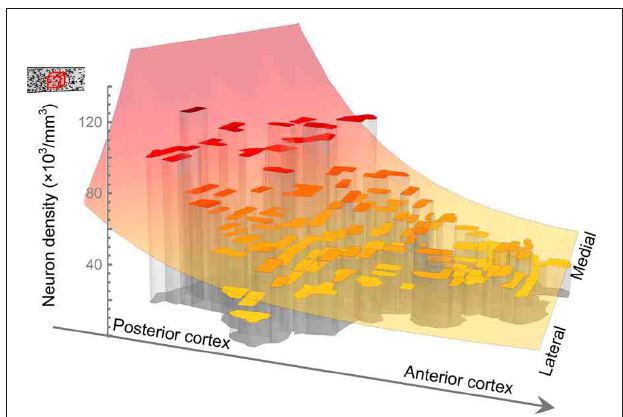
FIGURE 1 | Fitting a model to neuron density recorded in each sample in baboon. Collins et al. removed and flattened the entire cortical sheet, cut it into samples and measured the density of neurons and number of neurons in each. The outlines of the samples of Collins et al. are as represented here and the height of each surface indicates the density of neurons measured in the corresponding sample. Also illustrated is the model function, increasing along an axis from anterior-lateral to posterior-medial cortex, which we have fitted to describe the global trend in neuron